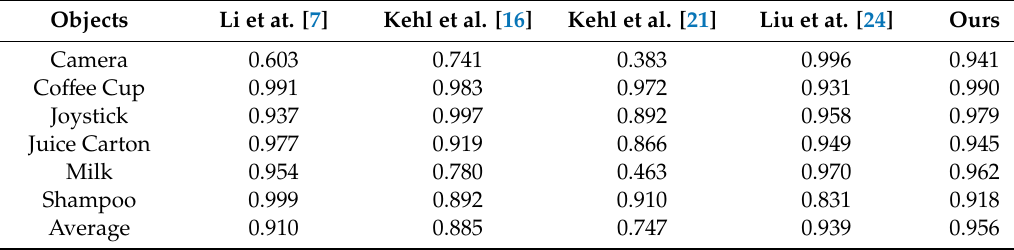
Table 1. F1-scores of methods on the Tejani dataset.